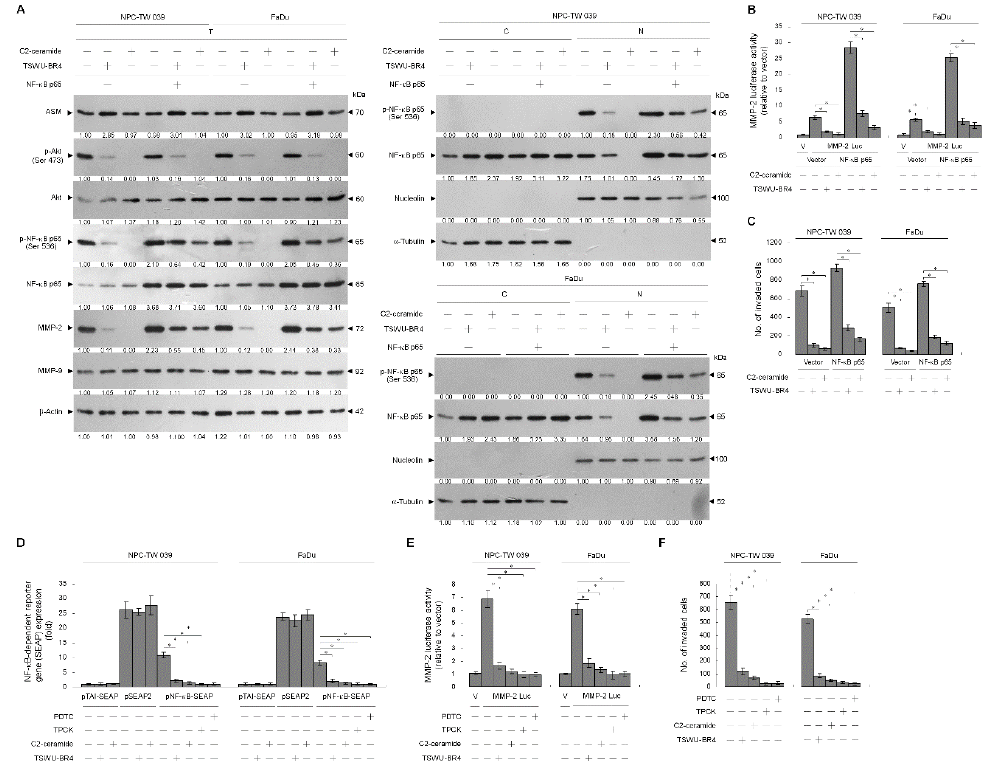
Figure 6. Ceramide generation is involved in TSWU-BR4-induced inhibition of GRP78 − PI3K − Akt − NF- κ B-mediated MMP-2 expression and cellular invasiveness. ( A ) At 12 h after transfection with the indicated plasmids, the cells were treated with the indicated compounds for an additional 36 h. The levels of the indicated proteins in the whole-cell, cytosolic, and nuclear extracts were then determined with specific antibodies. α -Tubulin and nucleolin were measured as internal controls for the cytosolic and nuclear fractions. The invaded cell numbers were assessed by Matrigel invasion assays. The values are presented as the S.E.M. of three independent experiments. * p < 0.05: significantly di ff erent from the vehicle-treated and vector-transfected cells or C2-ceramide-treated and vector-transfected cells. ( B , C , D , E ) At 12 h after co-transfection with the indicated reporter plasmids, the cells were treated with the indicated compounds for an additional 36 h. The SEAP, MMP-2 promoter, and invasive activities were then determined as described in Material and Methods. * p < 0.05: significantly di ff erent from the vehicle-treated, pNF- κ B SEAP-transfected cells; the vehicle-treated, MMP-2 promoter-transfected cells; or the vehicle-treated